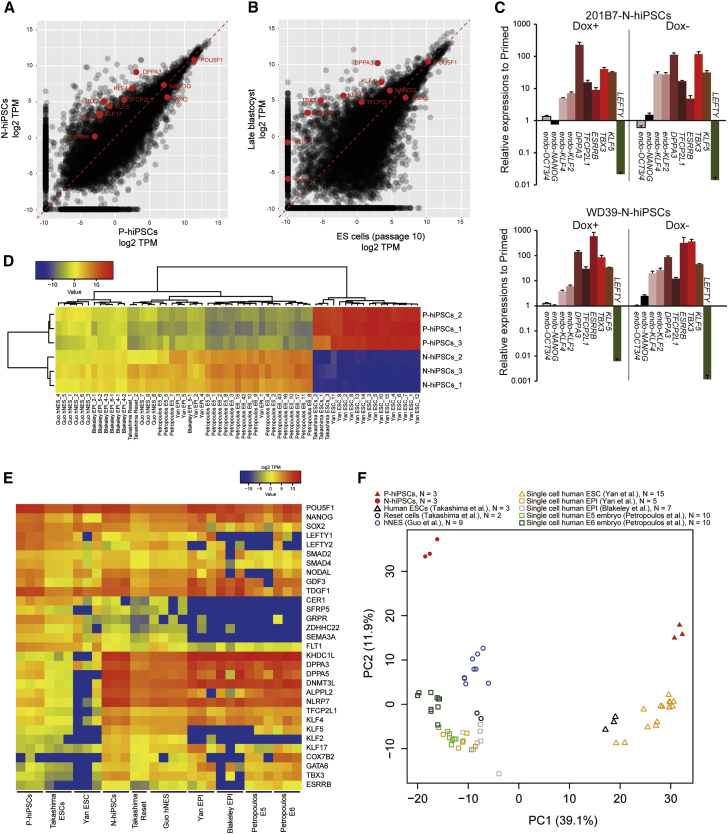
Gene Expression Analysis(A) Scatterplot of the P-hiPSCs versus the N-hiPSCs for the TPM values of each gene from RNA-seq data from this study.(B) Scatterplot of the hESCs versus the late blastocysts for the TPM values of each gene from the single-cell RNA-seq data from the study of Yan et al. (2013).(C) qPCR analyses of the gene expressions in the N-hiPSCs cultured in 2iLFA + Go (N2B27) before and after the withdrawal of Dox and in the primed counterparts. The reddish bars represent naive marker genes and the green bar represents a primed marker (n = 3; mean ± SEM; independent experiments).(D) Correlation matrix of the TPM values from the RNA-seq data from this study and the studies of Yan et al., 2013, Takashima et al., 2014, Blakeley et al., 2015, Petropoulos et al., 2016, and Guo et al. (2016).(E) Heatmap of the TPM values for selected genes from the RNA-seq data from this study with each dataset described above.(F) Principal component (PC) analysis of RNA-seq data from this study with each dataset described above.